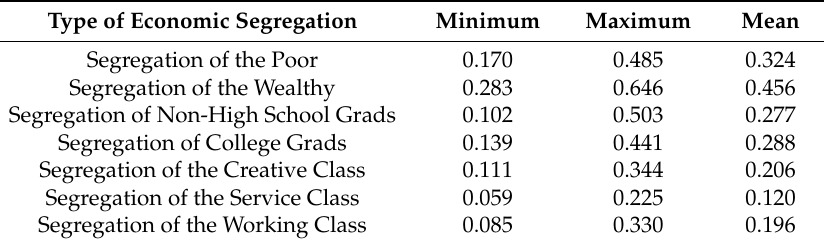
Table 2. Scores for Different Measures of Economic